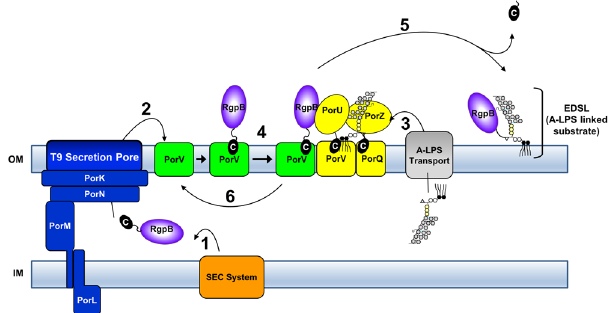
Figure 9. Model of Type IX Secretion. T9SS substrates have a conserved C-terminal domain (CTD) that directs their secretion across the outer membrane (OM). Substrates such as RgpB and also the T9SS components PorU and PorZ are transported across the inner membrane (IM) via the SEC translocon via their N-terminal leader sequence (Step 1). They are then secreted across the OM via the T9SS translocation apparatus that we propose includes PorK, PorL, PorM, PorN and possibly others, and secreted proteins are held on the cell surface through interaction with PorV (Step 2). The A-LPS anchor is independently transported to the outer leaflet of the OM (Step 3) and is recruited by the attachment complex consisting of PorV, PorU, PorQ and PorZ. PorV delivers the substrates to the PorU sortase (Step 4) for CTD cleavage and conjugation to the A-LPS anchor to produce the EDSL (Step 5). All members of the attachment complex are essential for Step 5 to occur. The cleaved CTD is then released to allow recycling of PorV (Step